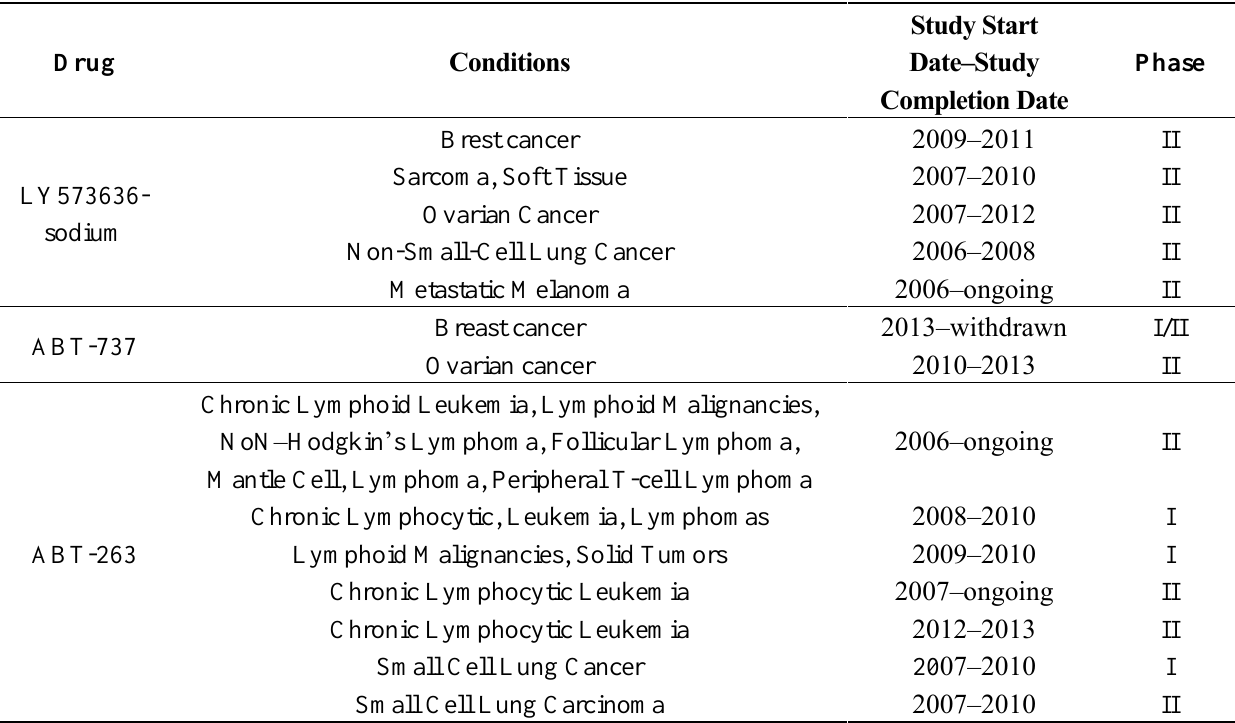
Table 1. Clinical Trial Information about LY573636-sodium, ABT-737, ABT-263 and ABT-199